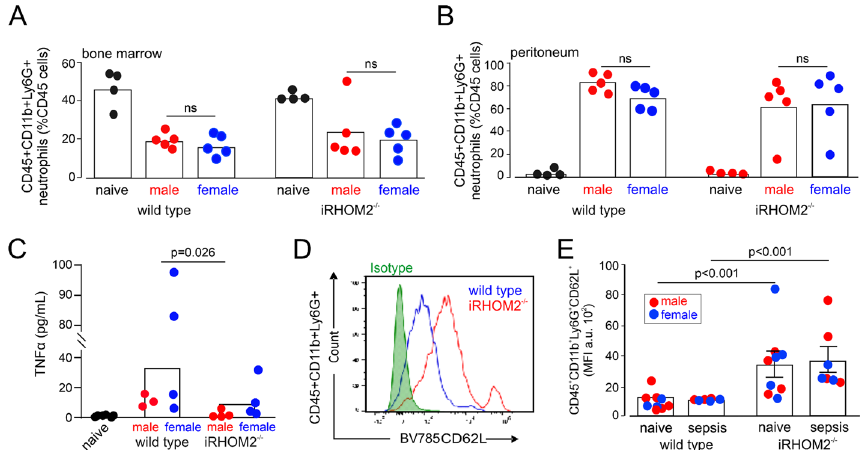
Fig. 7 Inflammatory response in iRHOM2-deficient female and male mice after polymicrobial sepsis. A Bone marrow and peritoneal enumeration of neutrophils before and after polymicrobial sepsis ( n 4–5 = mice/sex, as indicated). Similar numbers of neutrophils egressed from bone marrow and accumulated in the peritoneum 18 h after onset of sepsis. B Intraperitoneal TNFα protein levels were higher in wild-type mice ( n 7; p 0.026), compared with iRHOM2-deficient mice ( n 8), despite similar neutrophil infiltrates. = = = C Surface CD62L expression in neutrophils obtained from wild-type and iRHOM2-deficient mice. This representative data show that CD62L surface expression declines in wild-type mice after sepsis, but fails to be shed from the neutrophil cell surface in iRHOM2-deficient mice (Additional file 1: Supplementary data for summary